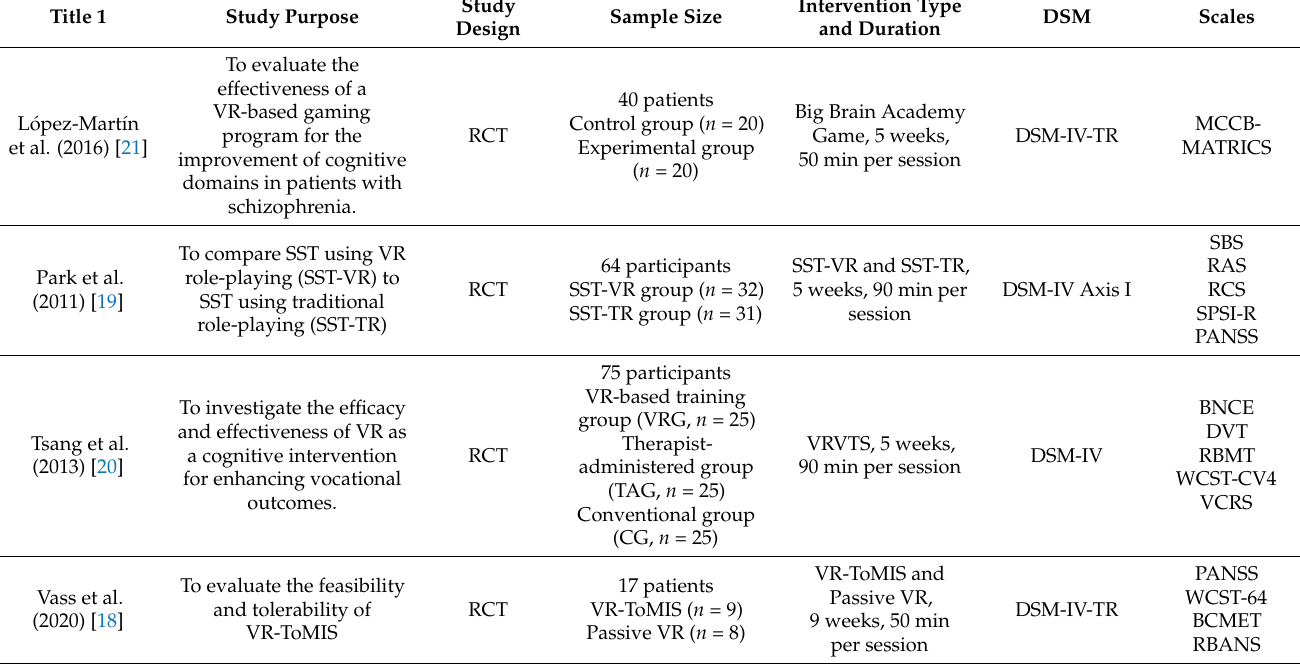
Table 3. Articles included in the review (sorted alphabetically by